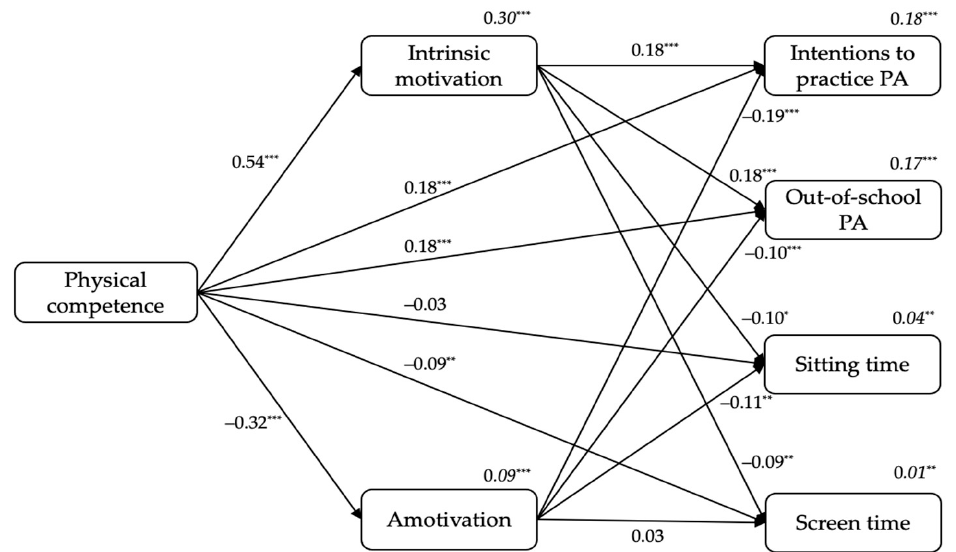
Figure 3. The standardized coefficients from students’ physical competence to intrinsic motivation and amotivation, and to outcomes. Note . * p < 0.05. ** p < 0.01. *** p < 0.001. On the other hand, students’ sex included in the model as a covariate positively predicted out-of-school PA levels ( β = 0.13, p < 0.001), whereas it negatively predicted sitting time ( β = − 0.12, p < 0.001) and screen time ( β = − 0.05, p <